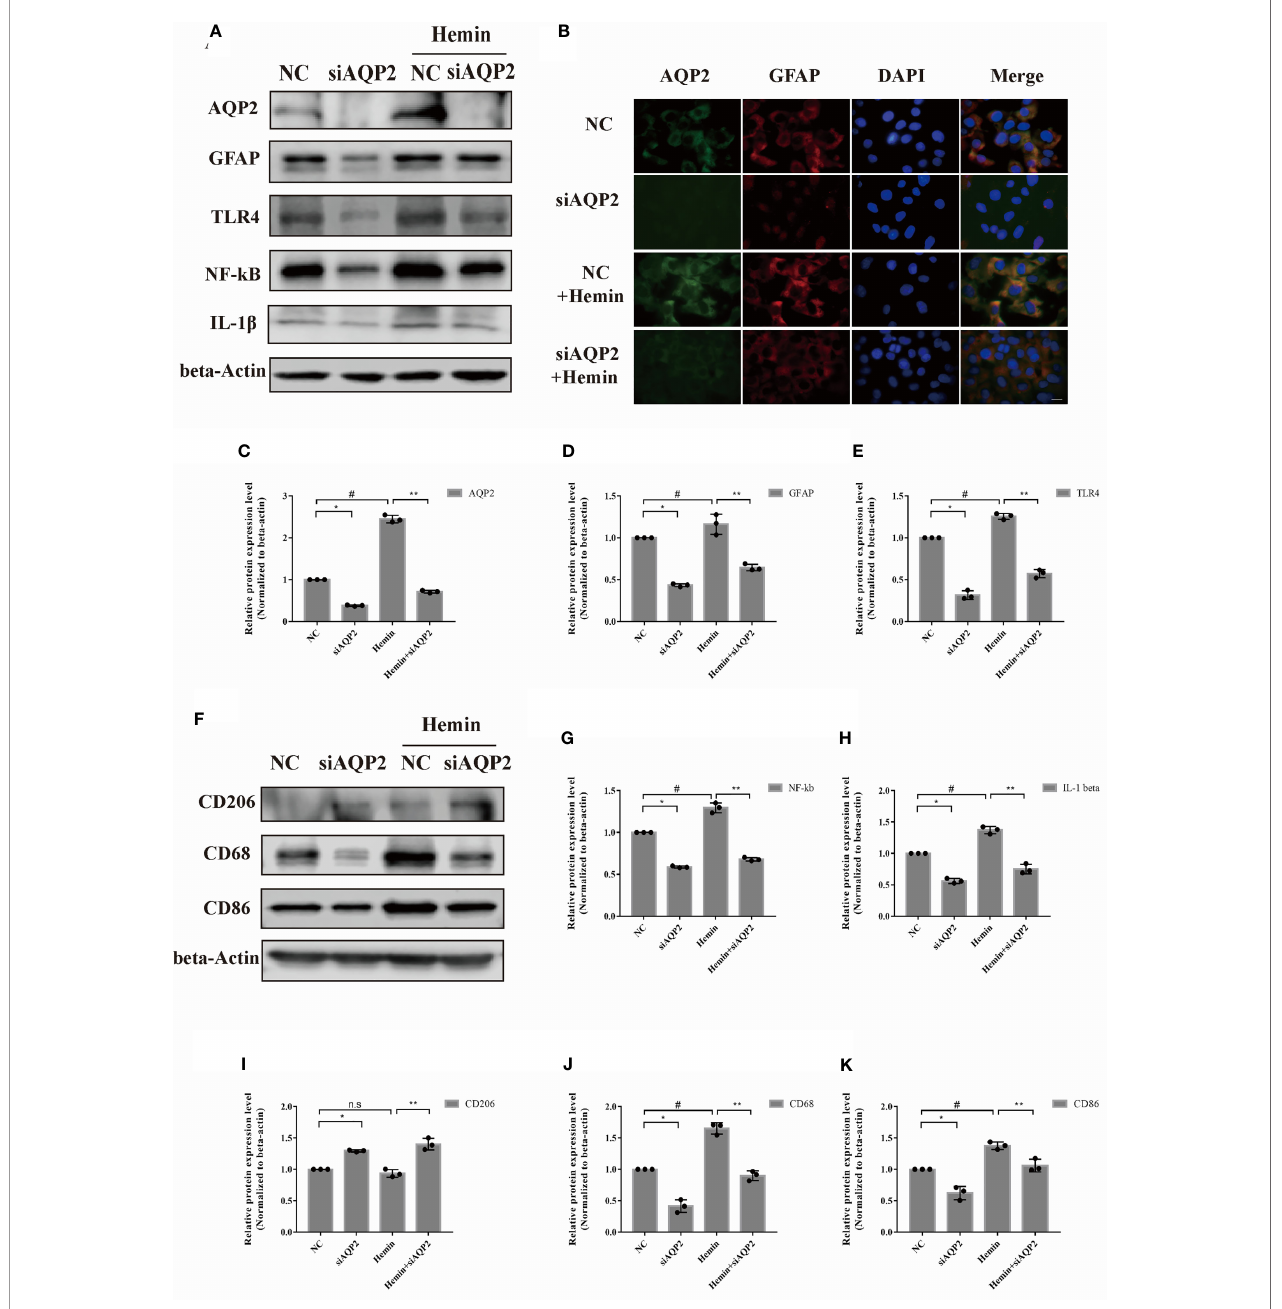
FIGURE 5 | AQP2 silencing directly inhibit astrocyte activation and indirectly reduce microglia migration. (A) Astrocyte were transfected with siAQP2 or siRNA-NC, and expression of AQP2, GFAP, TLR4, NF-kB and IL-1 b were assessed by western blotting (n = 3/group). (B) Immuno fl uorescence of AQP2 (red signal) and GFAP (green signal) in astrocyte in astrocyte treated with siAQP2 or siRNA-NC. Astrocyte cell nuclei were immunostained (blue, DAPI). Scale bar: 10 m m. (C – E, G, H) Quanti fi cation of the relative protein expression levels of AQP2, GFAP, TLR4, NF-kB and IL-1 b . (*p < 0.05 vs. siRNA-NC group; **p < 0.05 vs. siRNA-NC exposed to hemin; # p < 0.05 siRNA-NC group vs. siRNA-NC group exposed to hemin). The data are presented as the mean ± s.d. of three independent experiments. (F) Microglia were treated with medium of astrocyte for 24h transfected with siRNA or si-AQP2 RNA (with or without hemin). CD206, CD68 and CD86 were assessed by western blotting (n = 3/group). Quanti fi cation of the relative protein expression level of CD206 (I) , CD68 (J) and CD86 (K) is shown. (*p < 0.05 vs. siRNA-NC group; **p < 0.05 vs. siRNA-NC exposed to hemin; # p < 0.05 siRNA-NC group vs. siRNA-NC group exposed to hemin). The data are presented as the mean ± s.d. of three independent